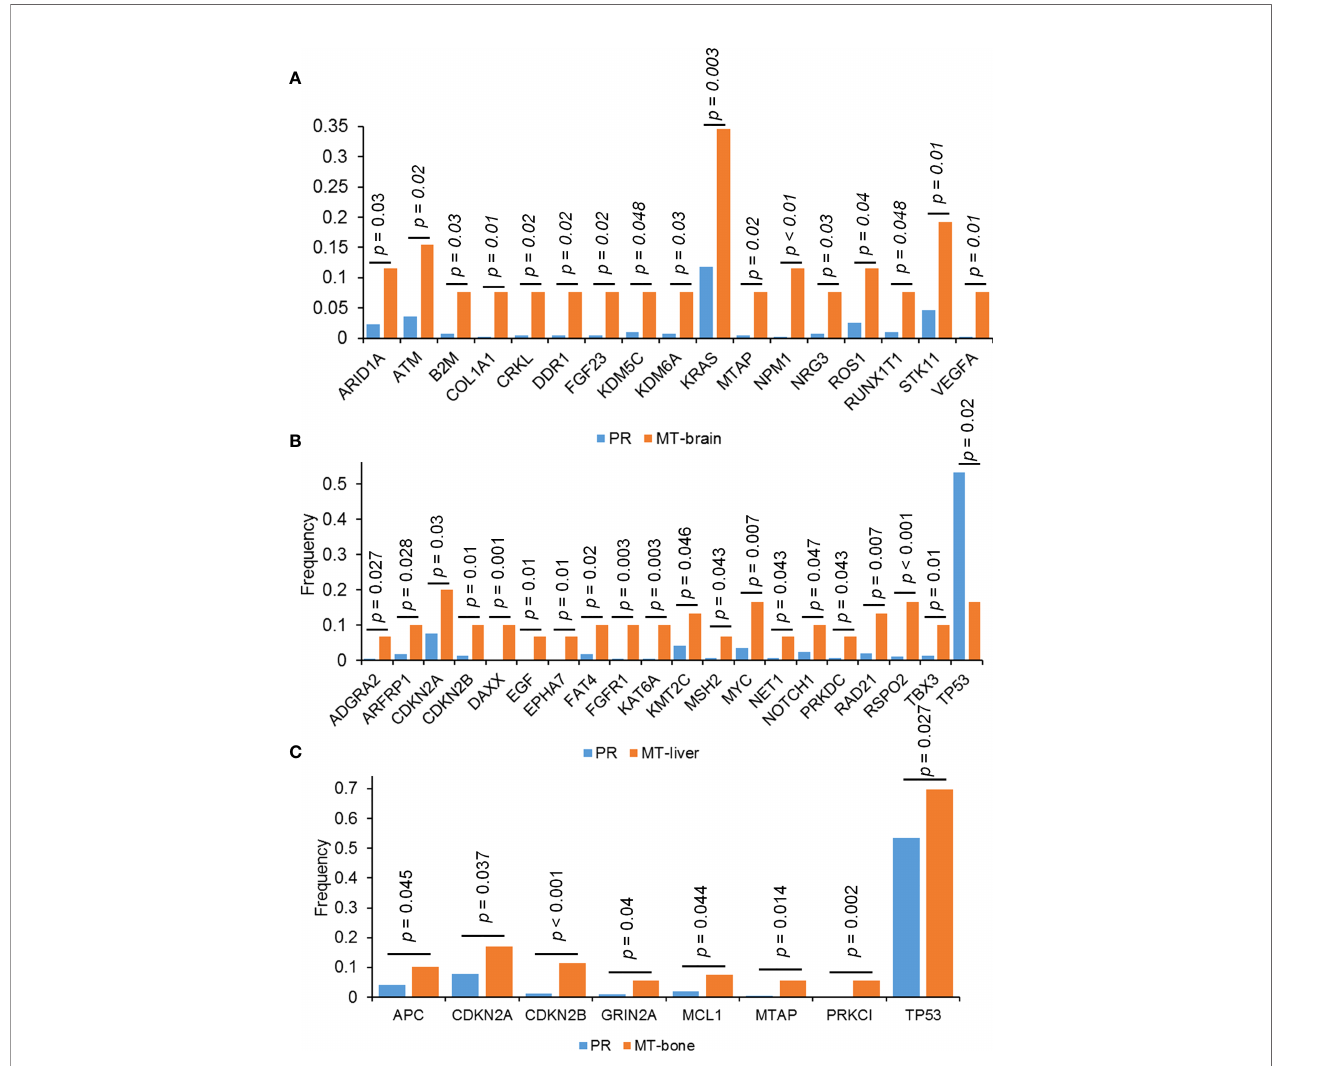
FIGURE 3 | The differences of genomic mutations between PR and metastases. The differences of genomic mutations between (A) PR and MT-brain, (B) PR and MT-liver, and (C) PR and